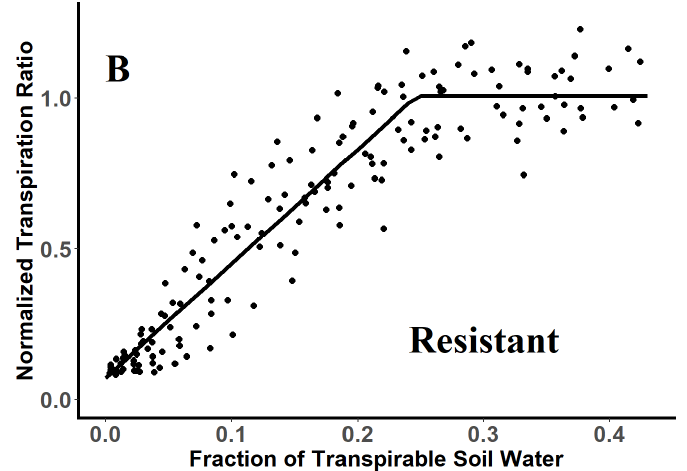
Figure 3. Relationship between normalized transpiration ratio (NTR) and fraction of transpirable soil water (FTSW) during soil drying cycle for glyphosate-susceptible (panel A) and -resistant (panel B) Palmer amaranth ( Amaranthus palmeri (S.) Wats.) accessions differing by their EPSPS gene copy